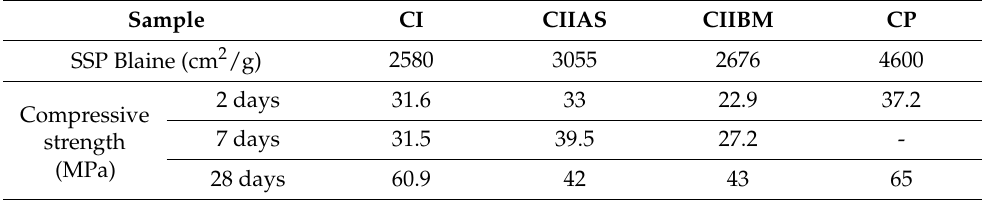
Table 2. Compressive strength of mortars at different hydration